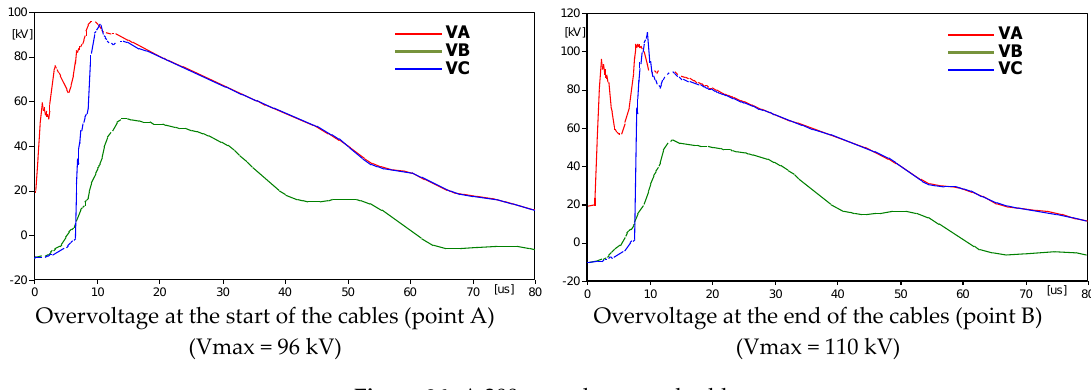
Figure 36. A 200 m underground cable.